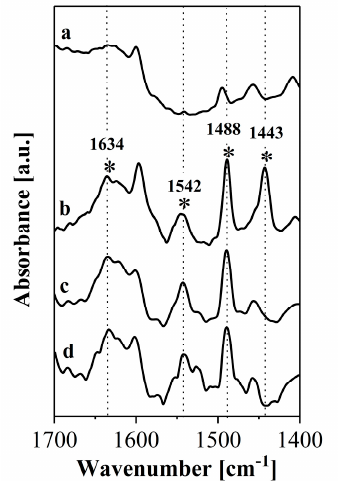
Figure 4. Fourier transform infrared (FTIR) spectra of M1 ‐ A: ( a ) before and ( b ) after pyridine adsorption, and after evacuation at ( c ) 150 ° C and ( d ) 200 ° C.